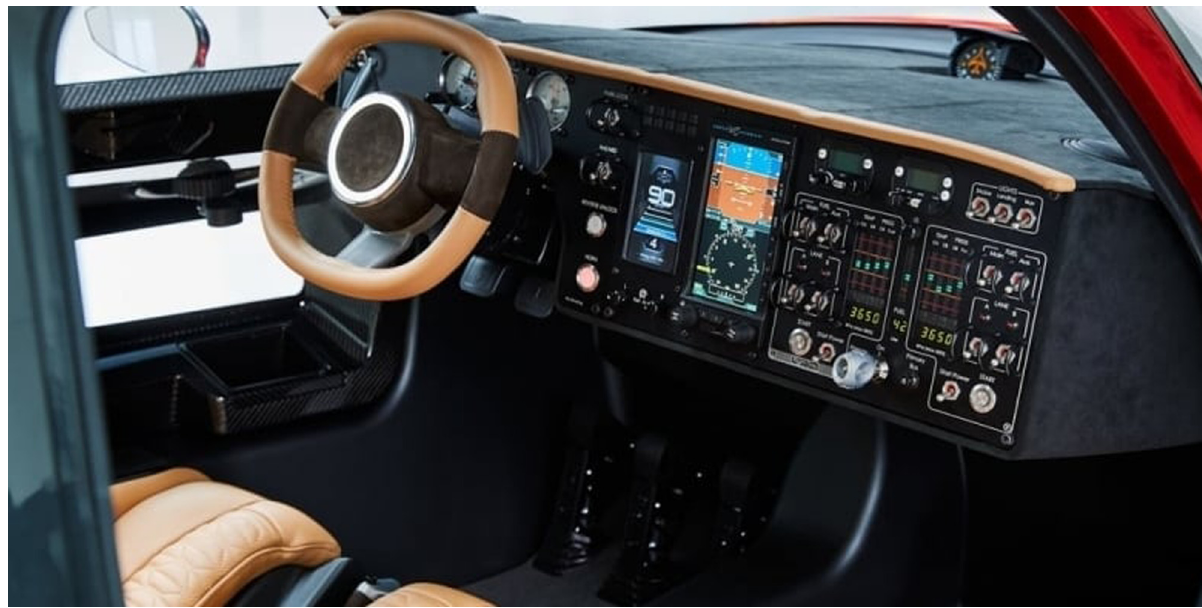
Figure 8: PAL - V Liberty Sport from the inside ( image credit: PAL - V International B.V., used with permission )